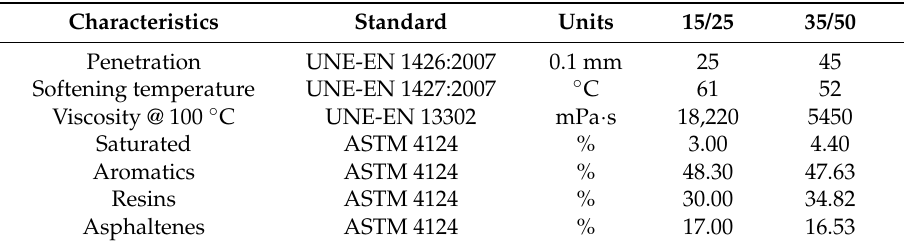
Table 1. Physicochemical characteristics of used bitumens.